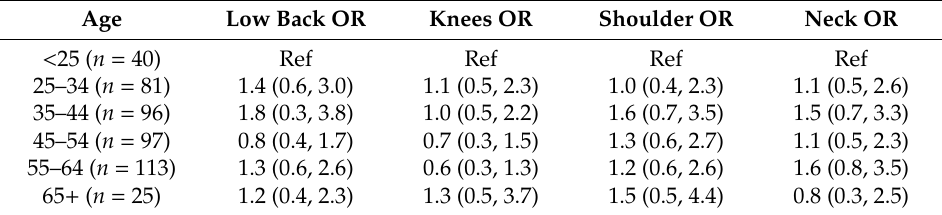
Table 6. Odds ratios of MSS by